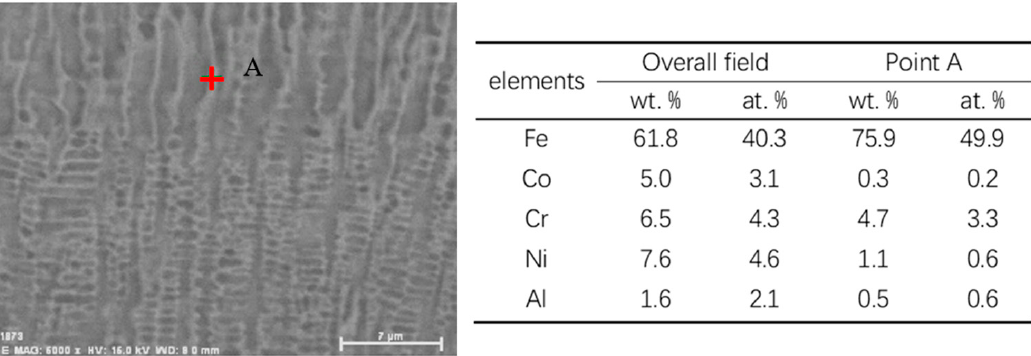
Figure 2. XRD pattern of 45 steel and Fe 6 CoCrNiAl coating.